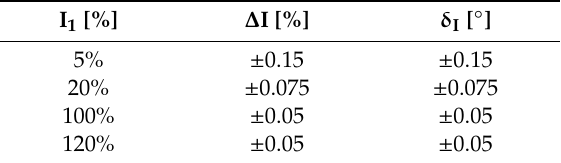
Table 1. Limiting values of current and phase errors for 0.05 accuracy class.